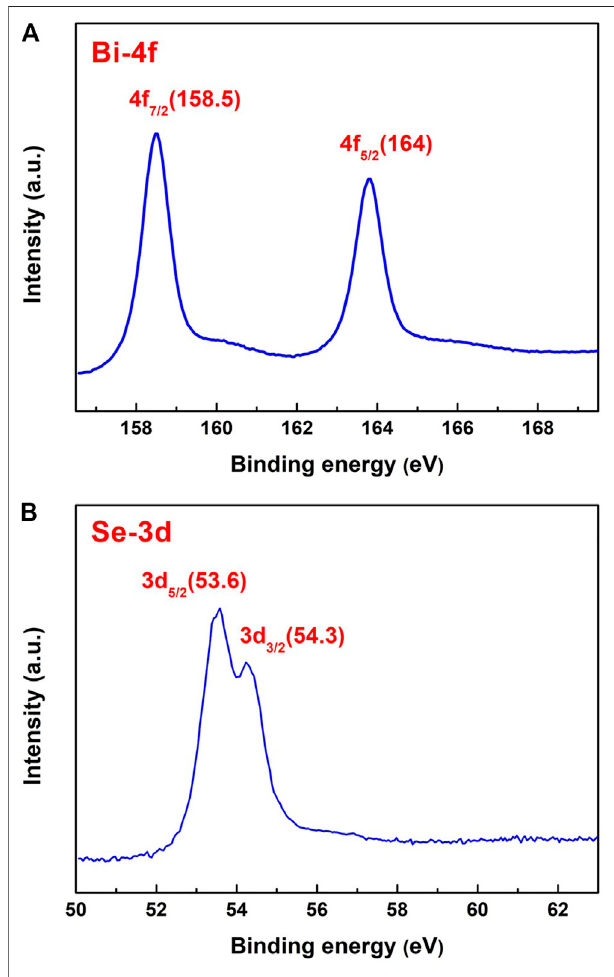
FIGURE1|(A) XRDpattern oftheBi 2 Se 3 singlecrystal fi lm, (B) Zoomed in XRD pattern of the Bi 2 Se 3 fi lm at (0015) peak.